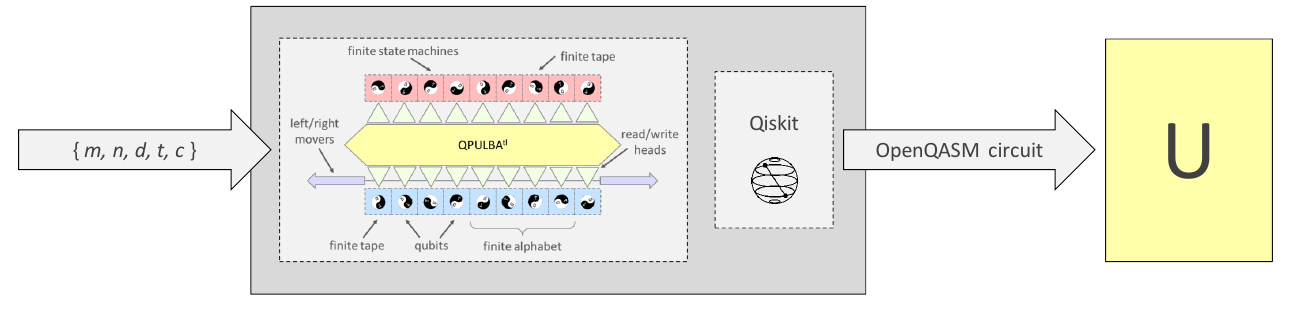
Figure 7. QPULBA circuit implementation, as detailed in